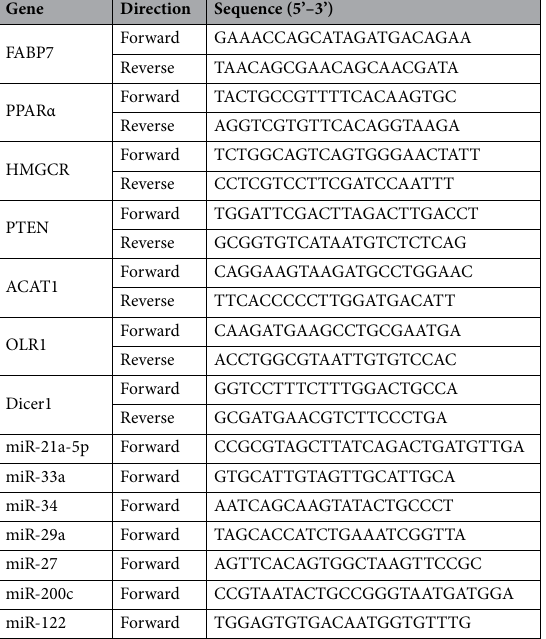
Table 1. Gene-specific